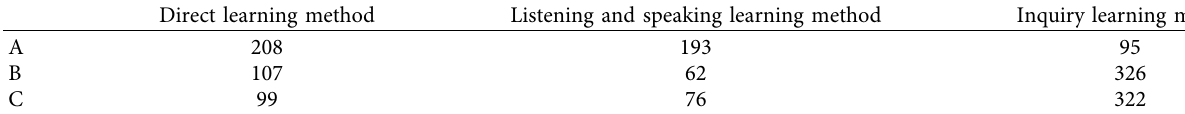
Table 3: Learning methods frequently used by physical education students.